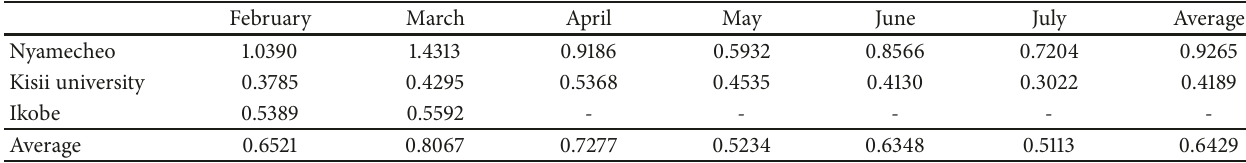
Figure 2: Six-month variation of wind shear coefficient for the three stations. Table 1: Averages of calculated wind shear